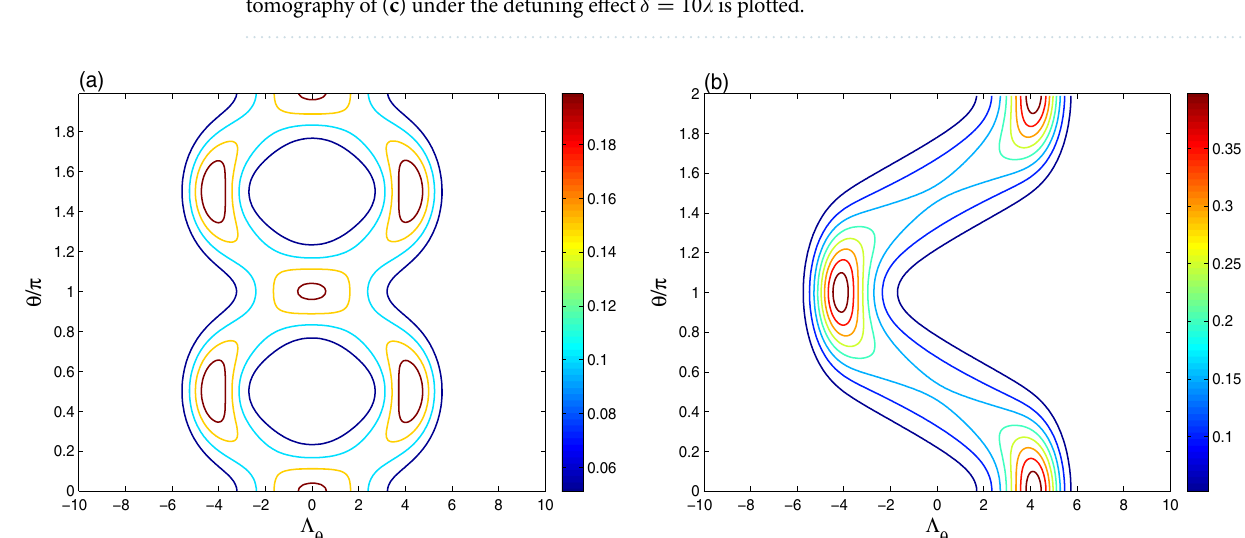
2 = 9 with 1 (cid:31) t = 1 (cid:31) t = π in ( c ). In ( d ), the optical 4 π in ( a ), 2 π in ( b ), and